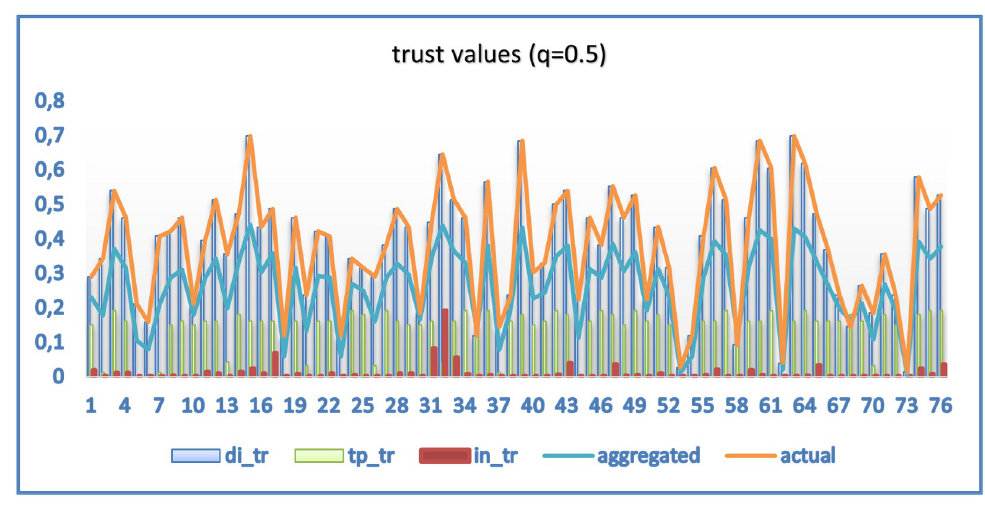
Fig 8. Averaged user trust distribution (q = 0.5).